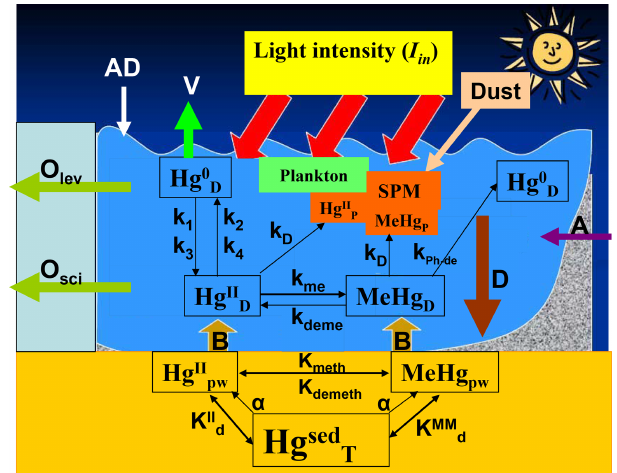
Figure 3. Basic scheme used for implementing the HR3DHG model. The scheme describes the transformation processes ( k 1 – photooxidation, k 2 – photoreduction, k 3 – biological oxidation, k 4 – biological reduction, k Ph-de – photodemethylation, k deme